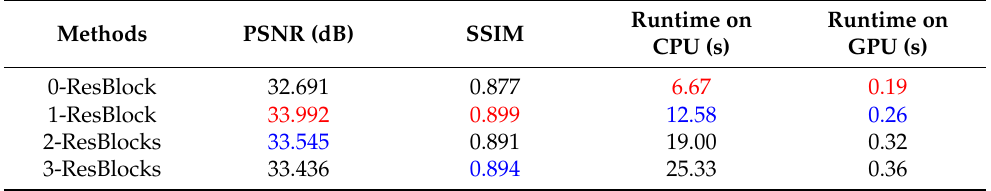
Table 5. Average PSNR, SSIM and Runtime of Ref-MFFDN with different layers of ResBlocks added in MFE. The highest score is highlighted in red, while the second-highest score is highlighted in blue.